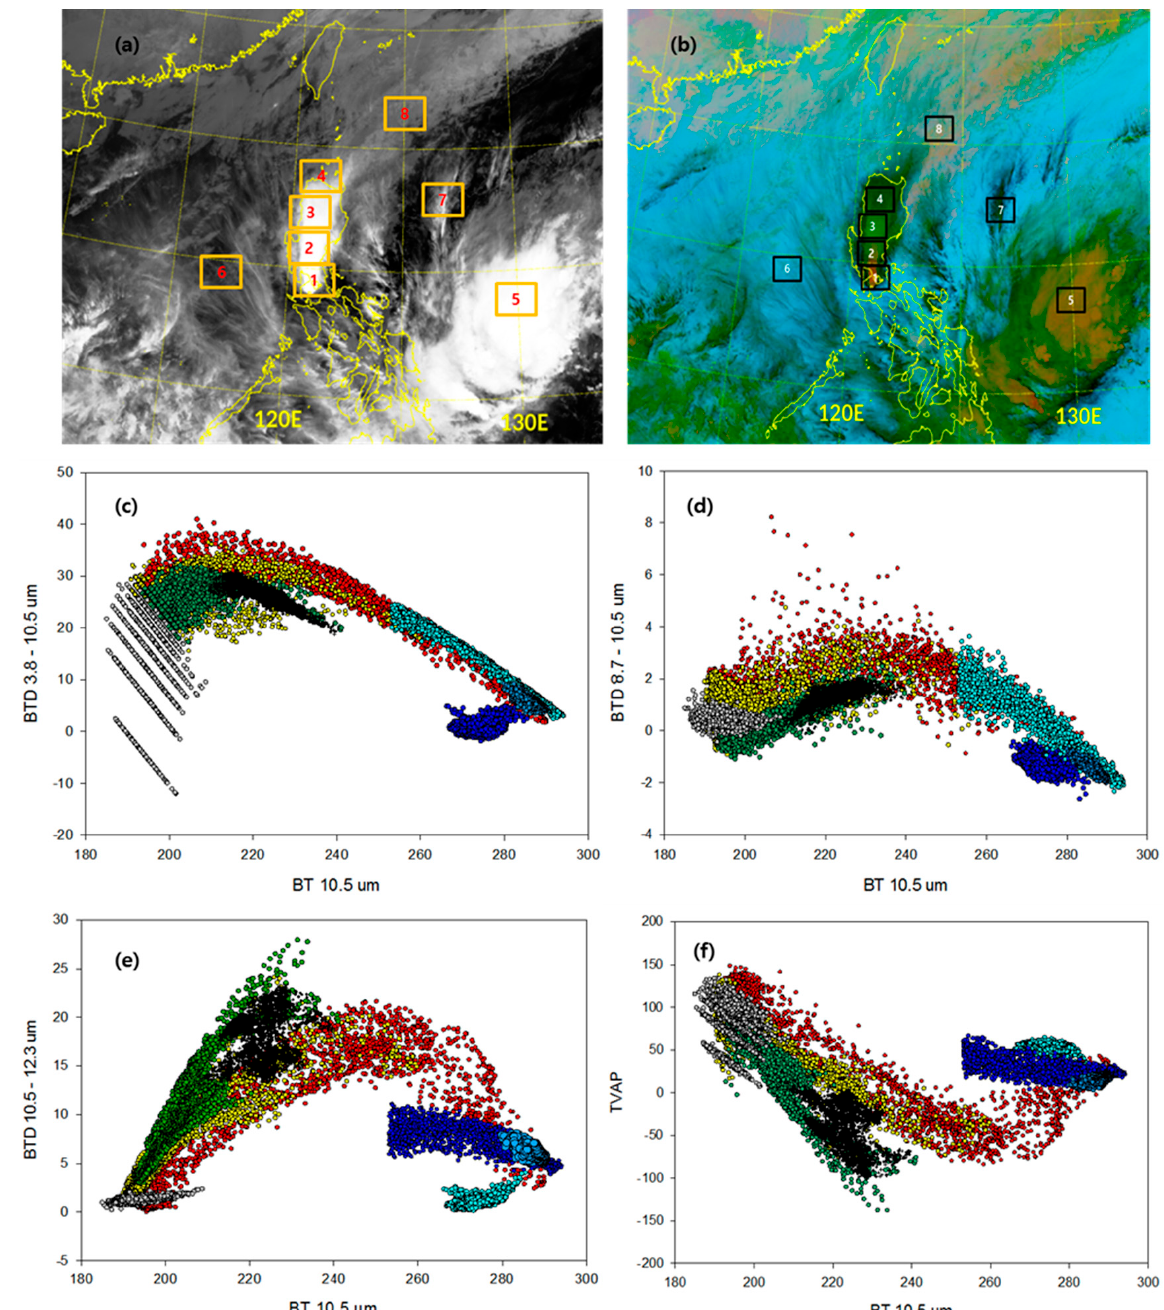
Figure 5. Interpretation of the Taal volcano scene divided by the color of the GK-2A Ash RGB (12 January 2020, 13:00 UTC). The images represent the GK-2A/AMI 10.5 μ m brightness temperature ( a ) and ( b ) GK-2A Ash RGB (area 1: ash (red), area 2: mixed (yellow), area 3: SO 2 (green), area 4: mixed (black), area 5: ice cloud (gray), area 6: clean (blue), area 7: cirrus (sky blue), area 8: water cloud (emerald)). Scatter plot between 10.5 µ m and each threshold test with ( c ) BTD 3.8–10.5 µ